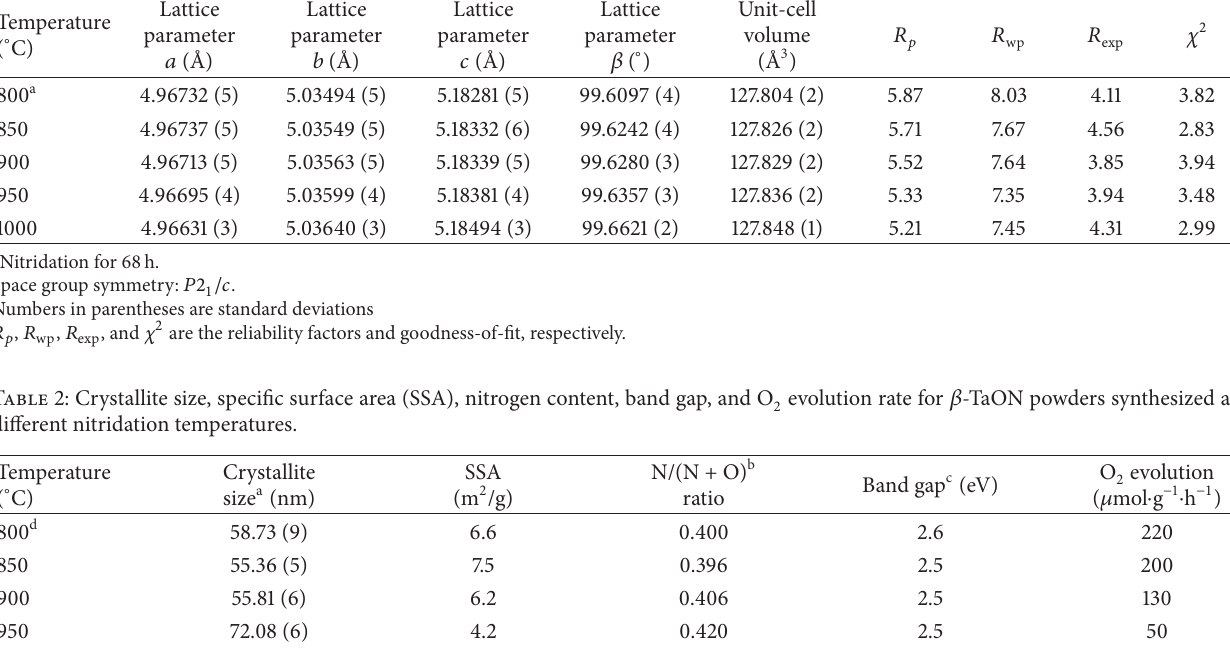
Table 1: Crystal structure parameters of 𝛽 -TaON powders derived from Le Bail fitting results.